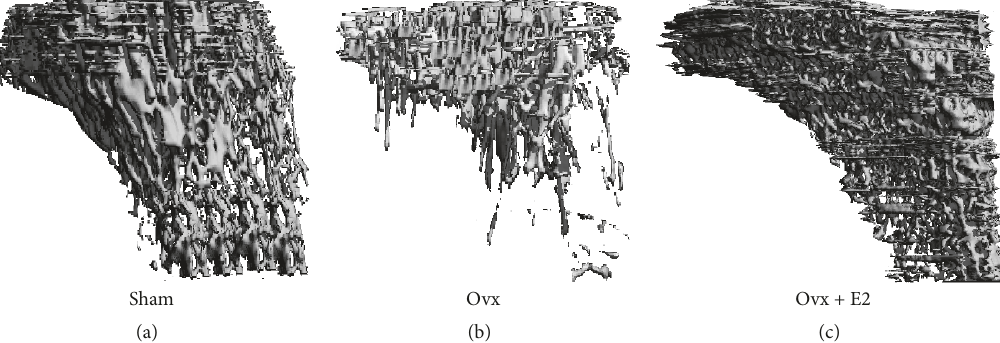
Figure 2: 3D trabecular images representative of proximal right tibia of sham (a), ovariectomy (ovx) (b), and 17 𝛽 -estradiol (ovx + E 2 ) (c). The images were acquired using 𝜇 CT (Methods). Ovariectomy decreased trabecular bone structure when compared to sham in rats from the cohort of initial age of ten months. This effect was prevented by E 2 administration. Similar effects were observed in younger animals ( 𝑛 = 6 per treatment